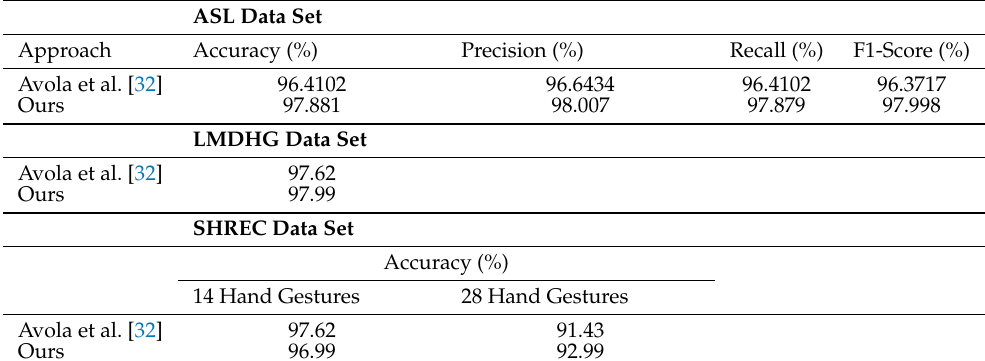
Table 12. Performance comparison of the multi-stacked BiLSTM network with method in